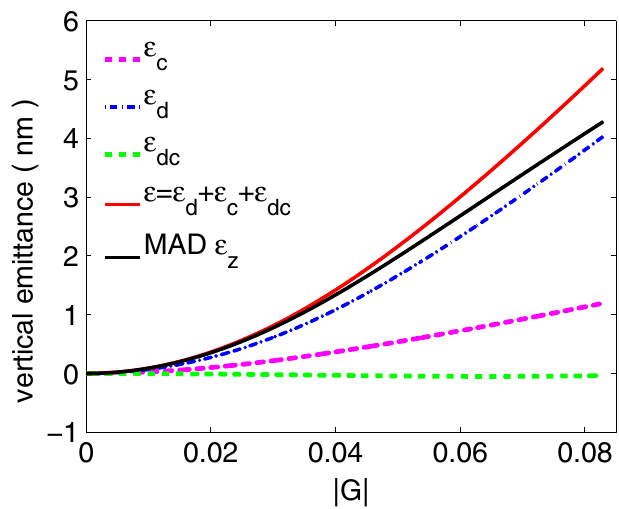
FIG. 1. (Color) The dispersion contribution (cid:7) , the coupling d , and the correlation (cid:7) for a low emittance contribution (cid:7) c dc QBA-lattice [1] are plotted vs the linear coupling strength G . The linear coupling strength is varied by a random roll of all quadrupoles in uniform distribution. Note that the correlation term is negligible. The analytical solution (cid:7) agrees well with that obtained in the MAD modeling for j G j (cid:12) 0 : 05 , where the beta- tron functions are not strongly